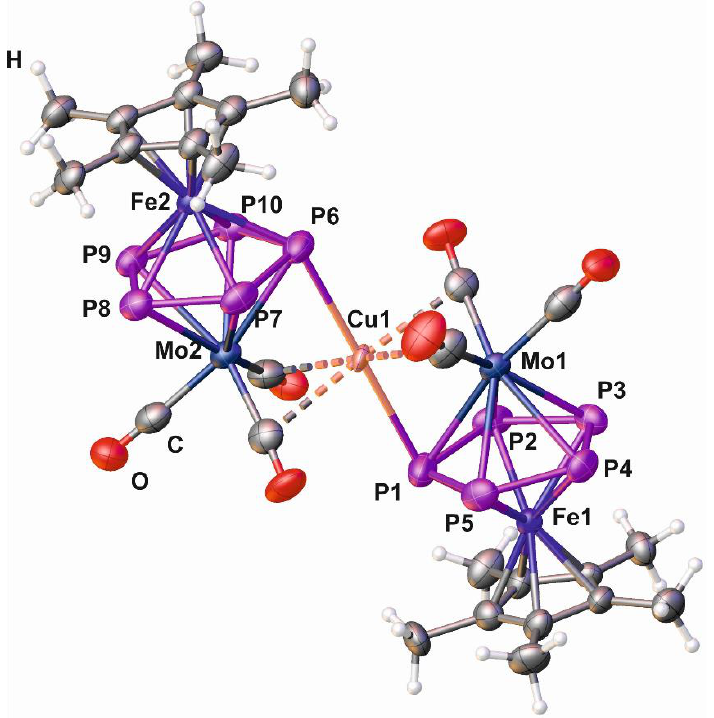
Figure 4. Molecular structure of the cation of 5 in the solid state.